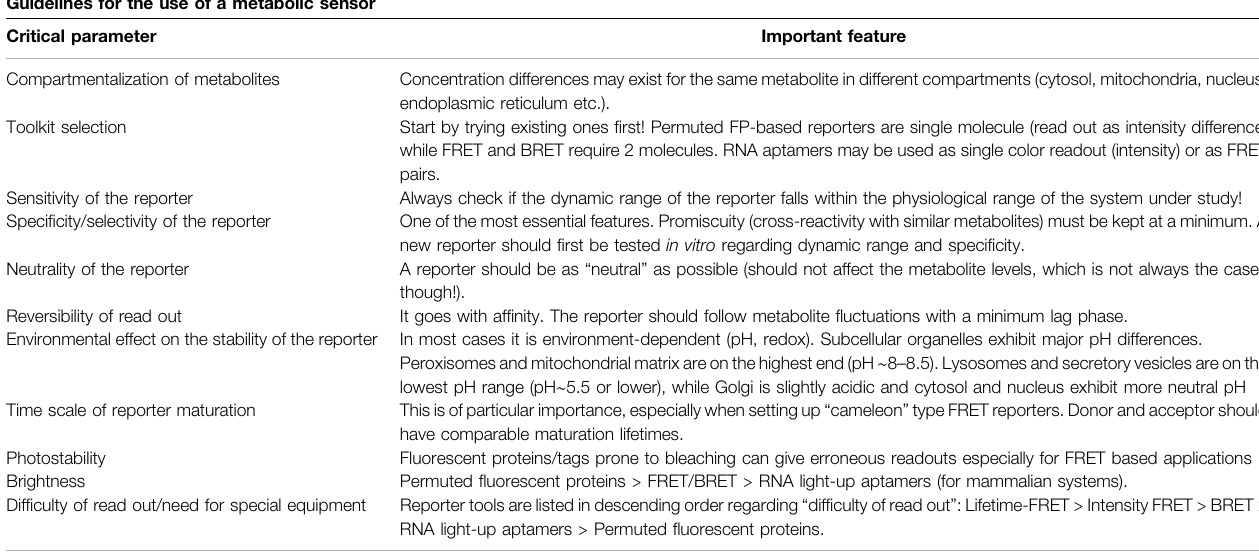
TABLE 2 | Basic requirements and features for the construction and use of a metabolite sensor. Guidelines for the use of a metabolic sensor Critical parameter Compartmentalization of